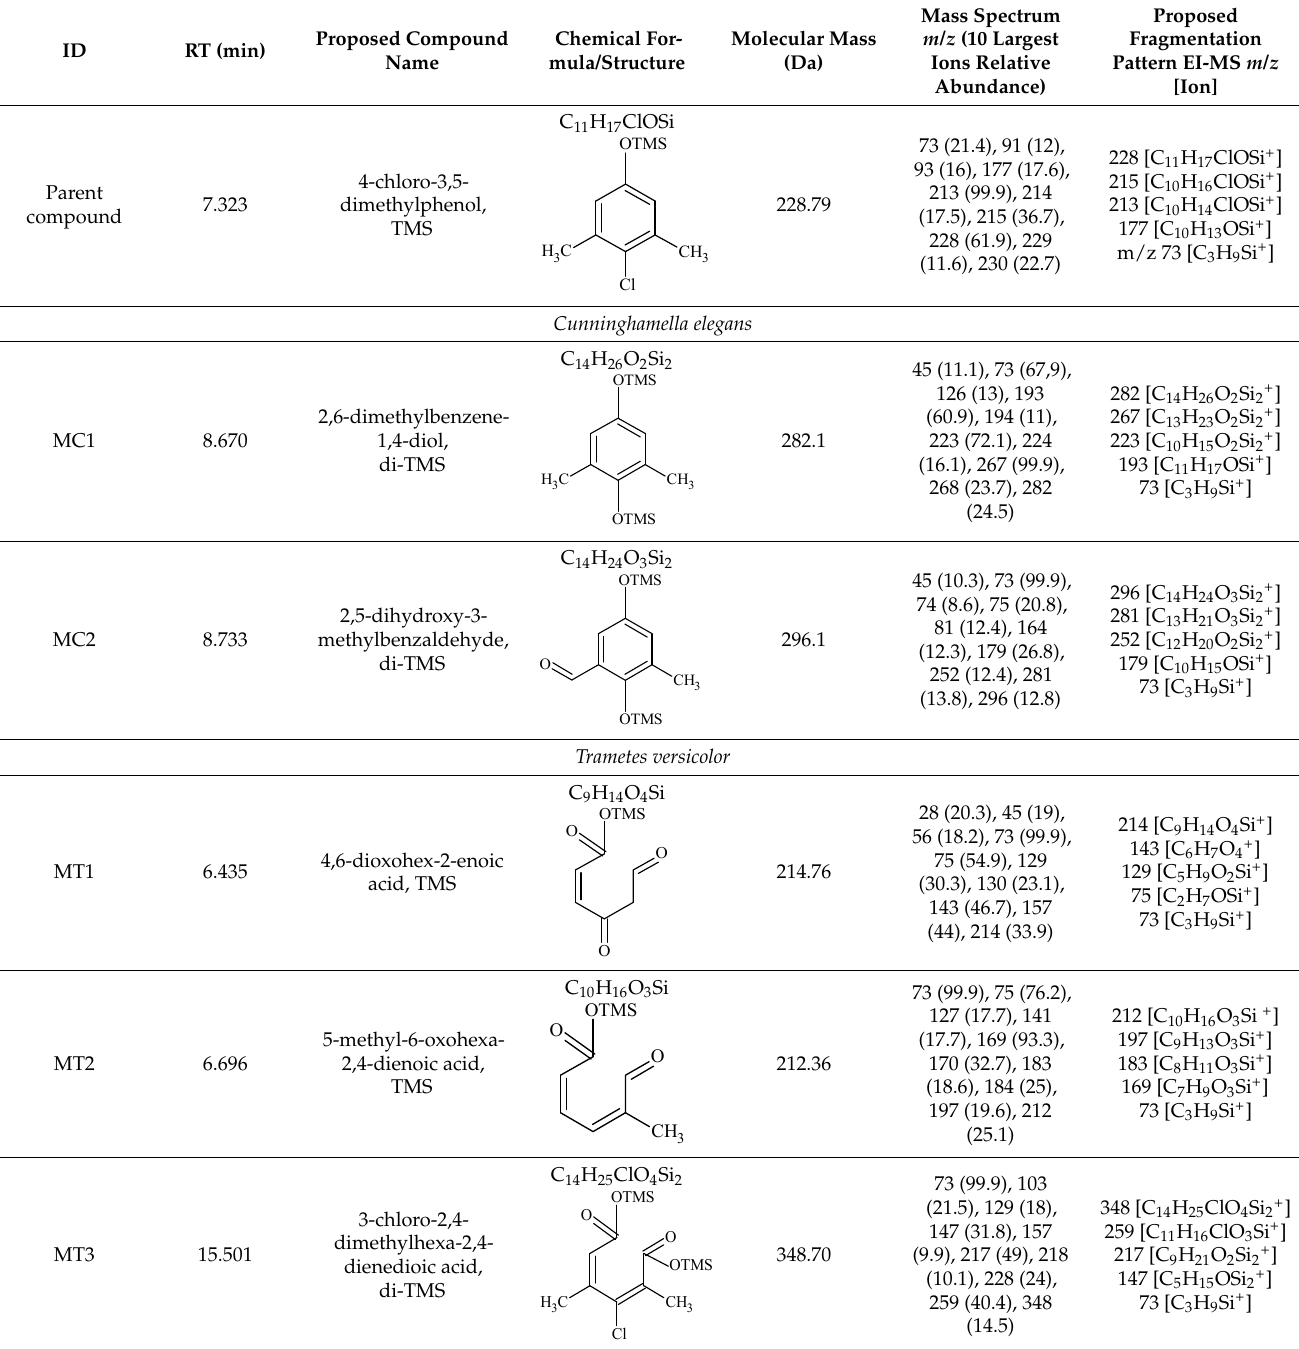
Table 1. Gas chromatography-mass spectrometry results of qualitative analysis of chloroxylenol degradation by C. elegans and T. versicolor .